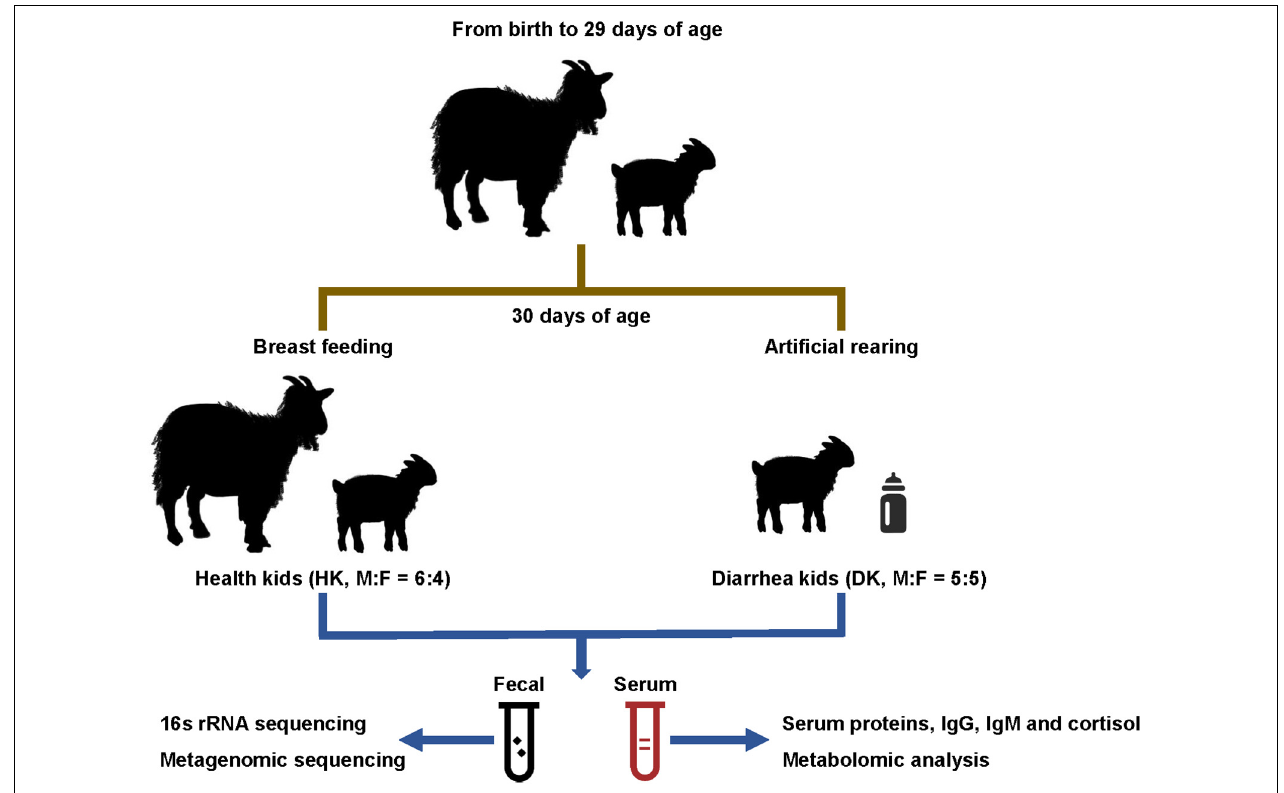
FIGURE 1 | Experimental design and